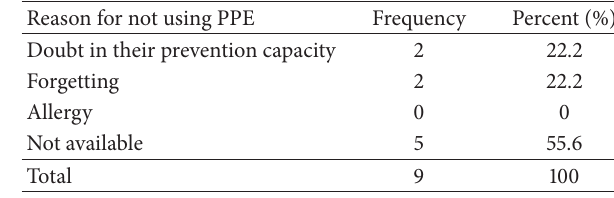
Table 2: Perceived reason for not using personal protective equip- ment of healthcare workers in Debre Berhan town, 2014.